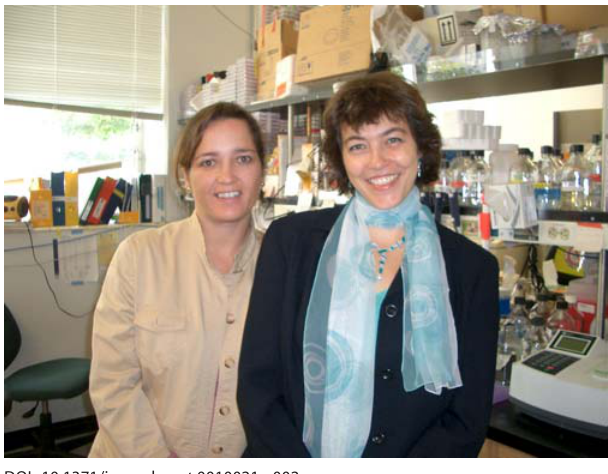
DOI: 10.1371/journal.ppat.0010021.g002 Figure 2. Josefina Coloma (left) and Eva Harris (right) in their laboratory at the School of Public Health, UC Berkeley (Photo: Jennifer